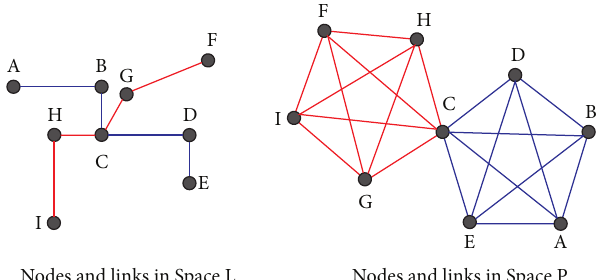
Figure 1: Explanation of Space L & Space P.